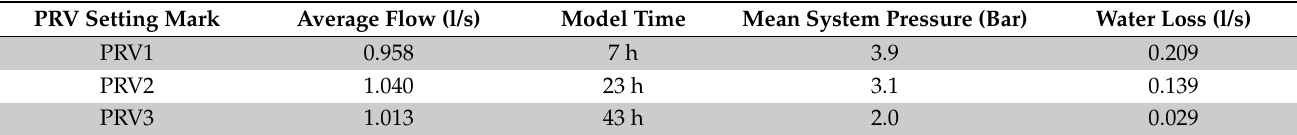
Table 4. Mean pressure